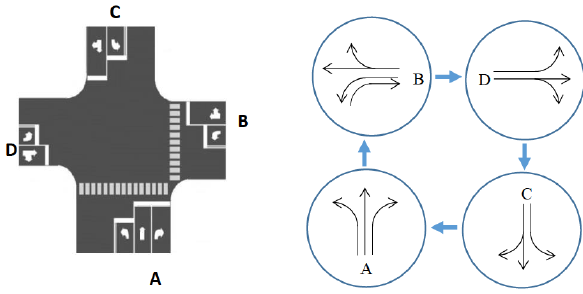
Figure 2: Diagram of driving lanes and sequence of control